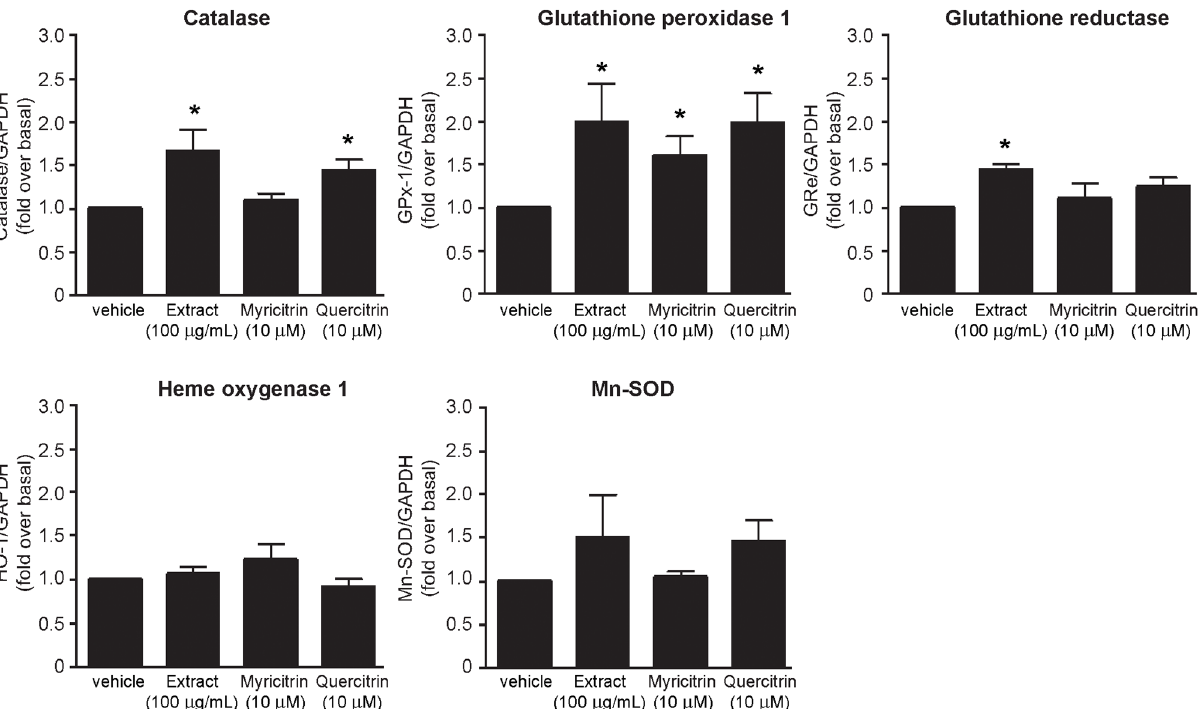
Figure 4. Effects of the methanol extract and flavonoid glycosides 7 and 8 from S. antisepticum on upregulation of antioxidant mRNA levels; HEK-293 cells were treated with either methanol extract of S. antisepticum (100 µg/mL), myricitrin ( 7 ) (10 µM), or quercitrin ( 8 ) (10 µM) for 6 h. The relative mRNA expression levels were quantified and shown as mean ± SEM as fold over basal (vehicle, DMSO) (n = 4). * p < 0.05 versus control.